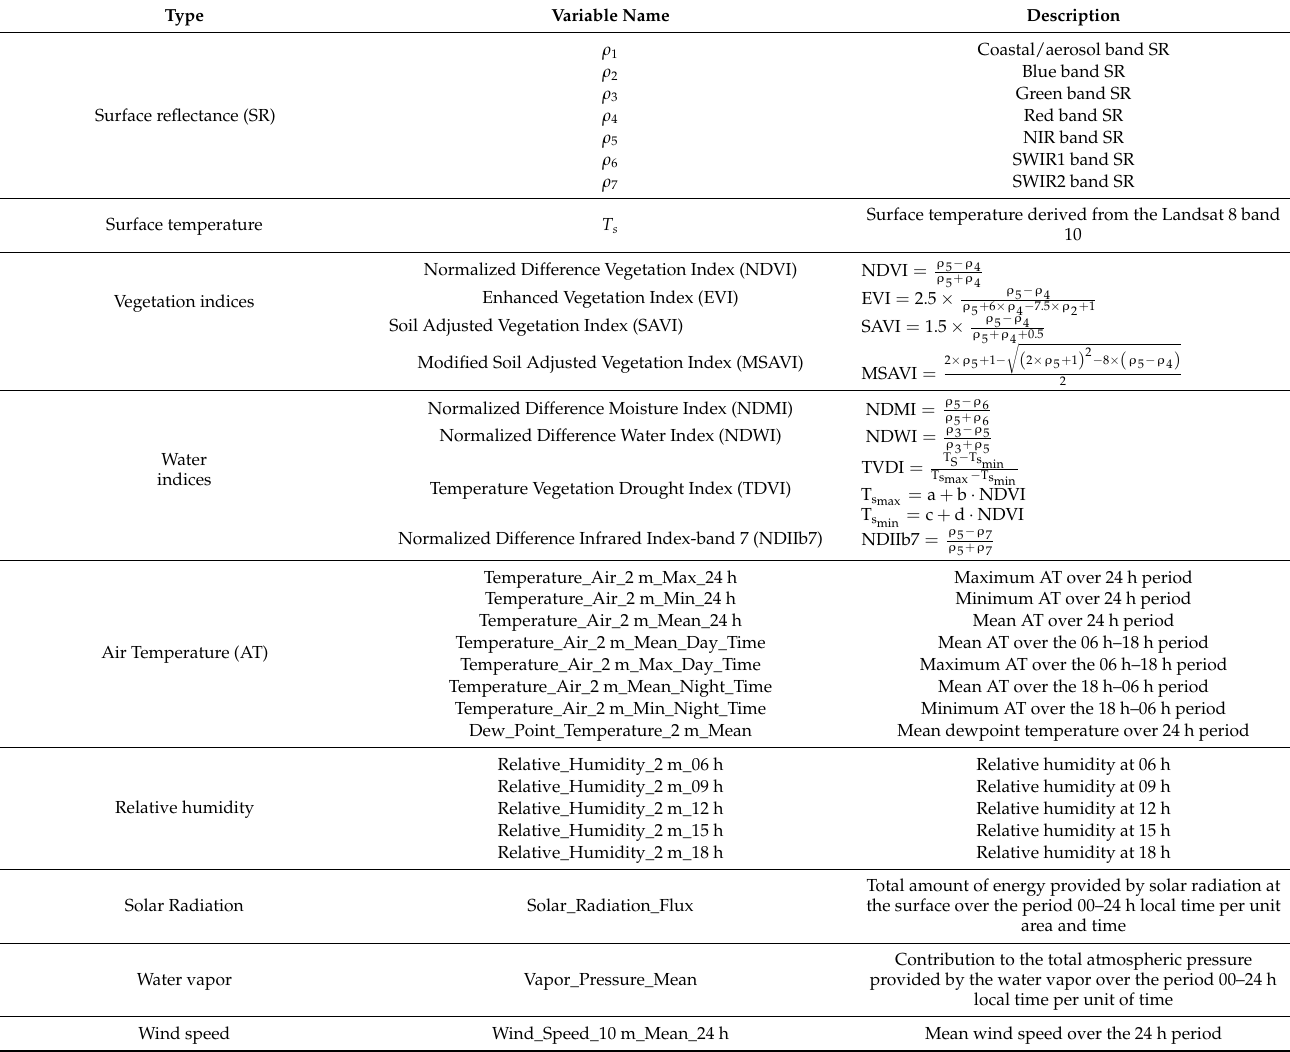
Table 2. Descriptions of the sixteen Landsat 8 and sixteen AgERA5